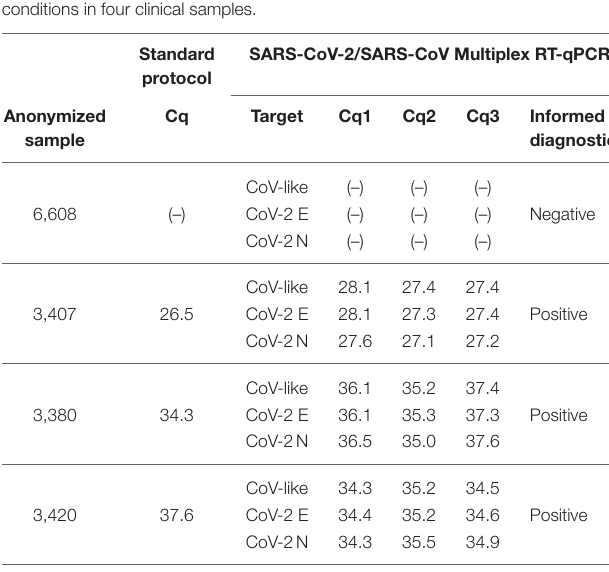
TABLE 2 | Repeatability and pre-validation of selected RT-qPCR protocol conditions in four clinical